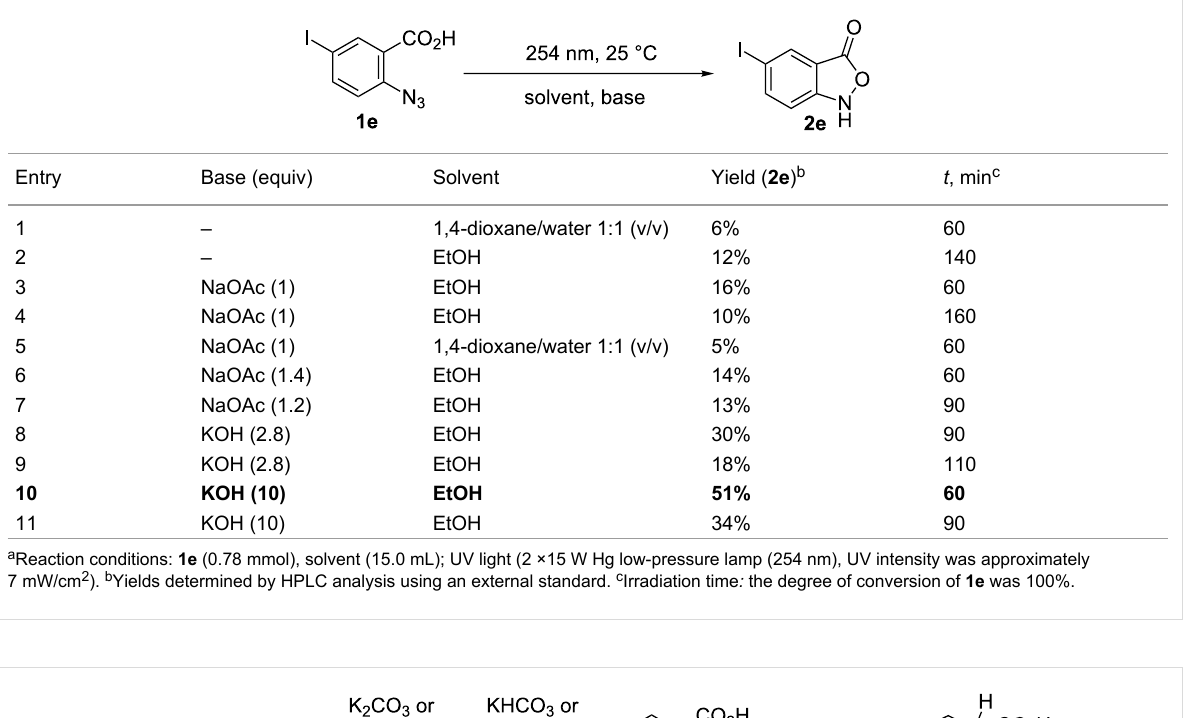
Table 4: Optimization of conditions for the synthesis of 5-iodo-2,1-benzisoxazole-3(1 H )-one ( 2e ).